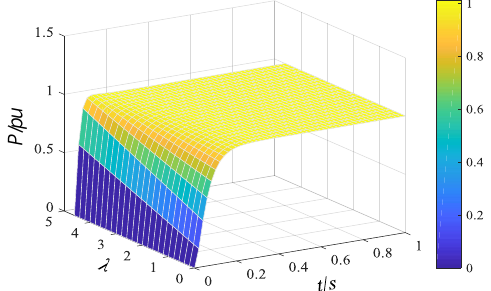
Figure 8. Step response of G r1 ( s ) with participation factor of direct power control λ varies .